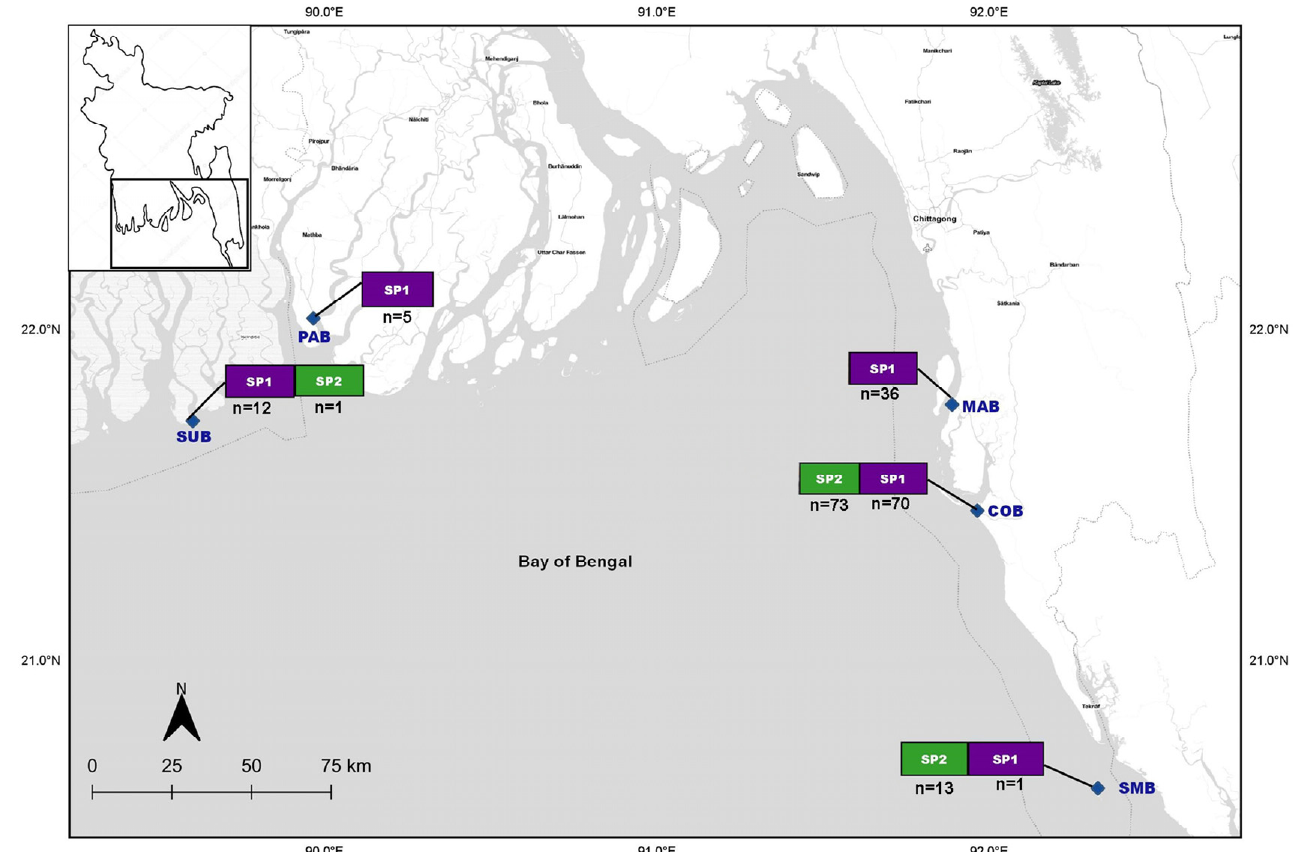
Figure 1. Sampling locations of two Sillago spp. nov. from the Bay of Bengal, Bangladesh. SUB: Sundarbans, PAB: Patharghata, MAB: Maheshkhali, COB: Cox’s Bazar, and SMB: Saint Martin’s Island, SP1: S. muktijoddhai sp. nov., SP2: S. mengjialensis sp. nov.; n is the number of individuals of each species at each